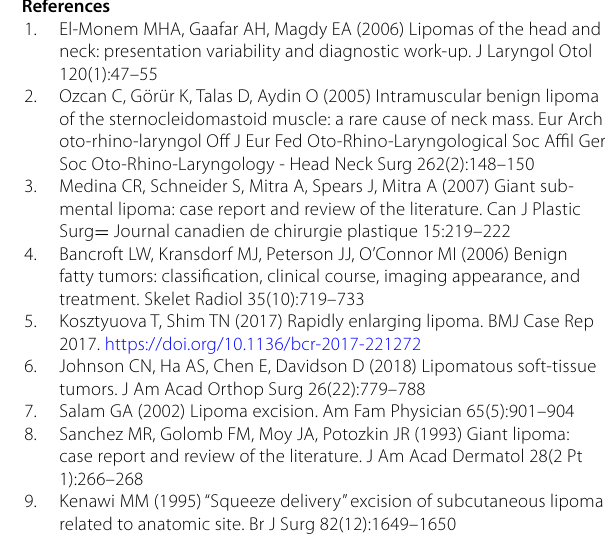
Fig. 4 Excisional biopsy and histopathology revealing a 13 3.5 cm neck